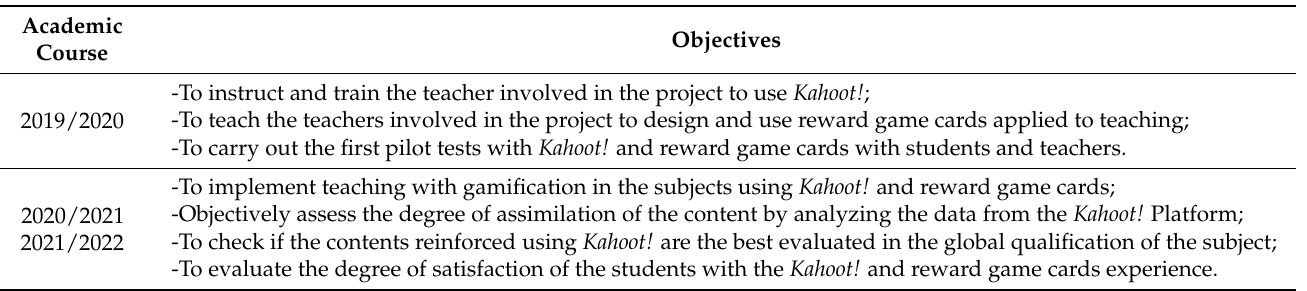
Table 2. Objectives of the Teaching Innovation Project using Kahoot!